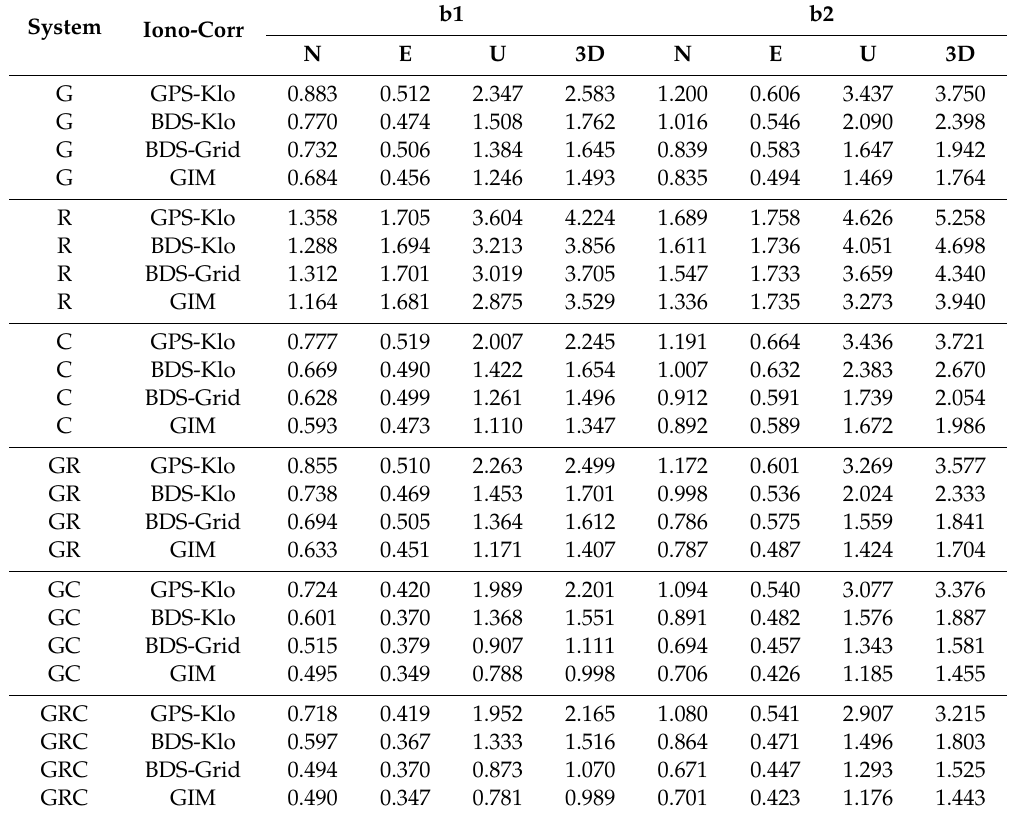
Table 2. RMS of SF-SPP with GPS-Klo, BDS-Klo, BDS-Grid and GIM based ionospheric correction for Figure 1 and b2 (unit: